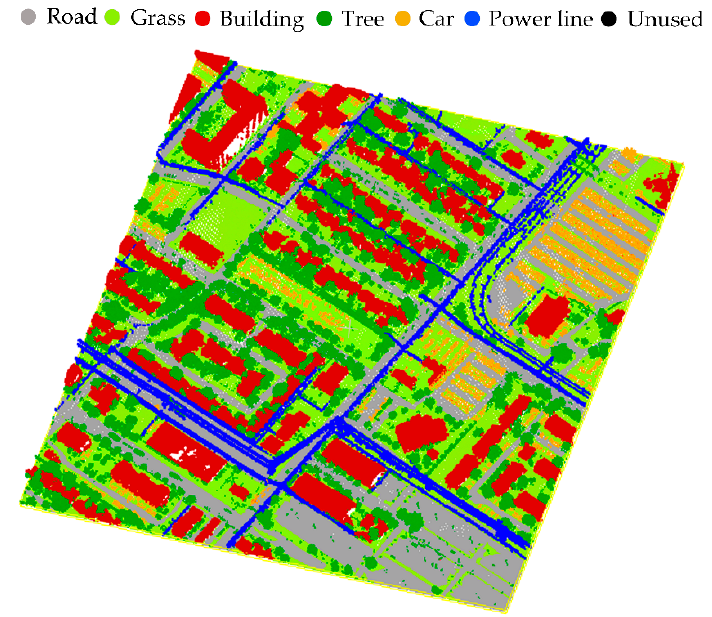
Figure 2. Reference multispectral LiDAR point cloud after pre-processing.